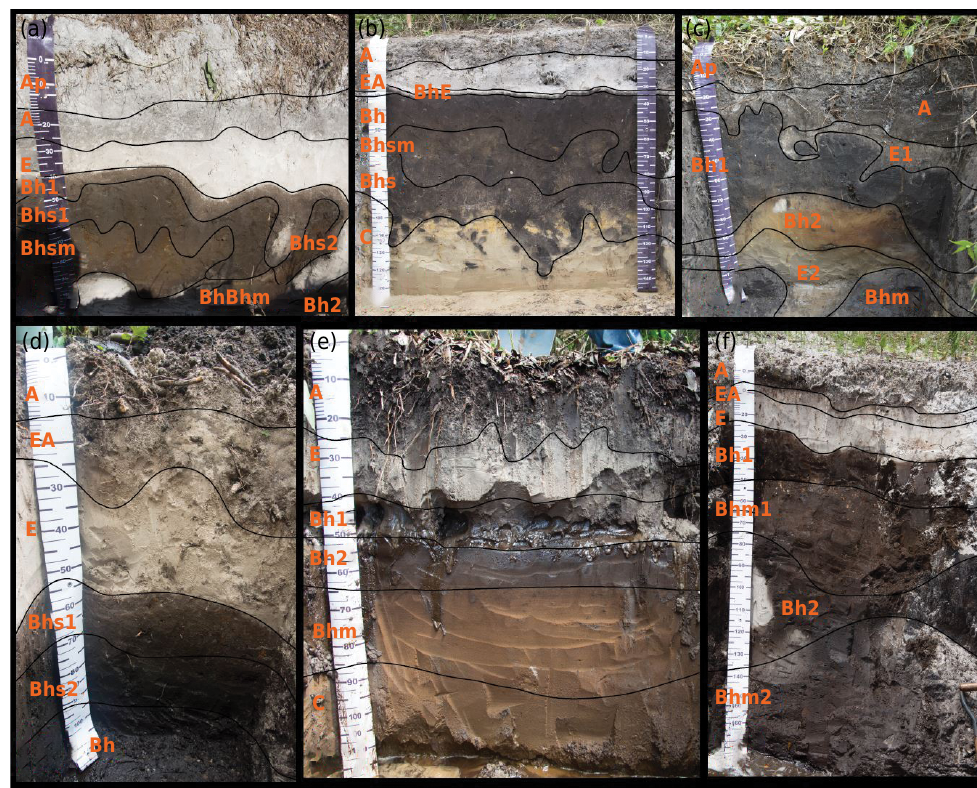
Figure 3. Profiles reclassified after calcination procedure: profile 6 reclassified from EK to ESK (a); profile 8 reclassified from EK to ESK (b); profile 12 reclassified from ES to EK (c); profile 14 reclassified from EK to ESK (d); profile 17 reclassified from ESK to EK (e); and profile 15 reclassified from ESK to EK